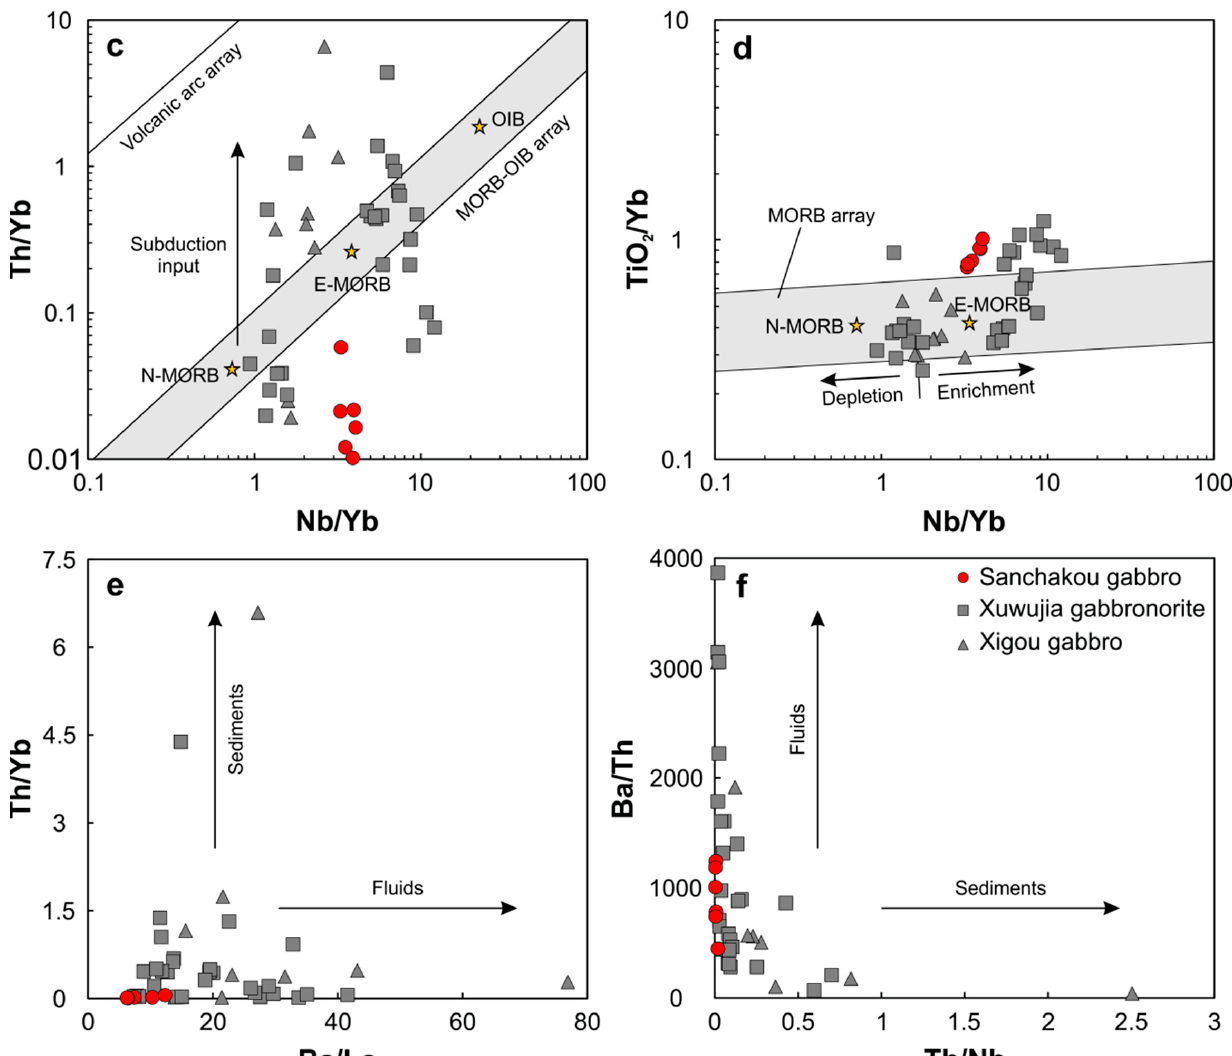
Figure 10. Geochemical diagrams of the Sanchakou gabbros. ( a ) The Sm/Yb versus La/Yb diagram (after [120]). ( b ) The Sm/Yb versus Sm diagram (after [107]). Solid and dashed curves are the melting trends from DM (depleted MORB) and PM (primitive mantle). ( c ) The Th/Yb versus Nb/Yb diagram (after [121]). ( d ) The TiO 2 /Yb versus Nb/Yb diagram (after [121]). ( e ) The Th/Yb versus Ba/La diagram (after [116]). ( f ) The Ba/Th versus Th/Nb diagram (after [115]). The major and trace elemental data of Xuwujia gabbronorites and Xigou gabbros are from [35].